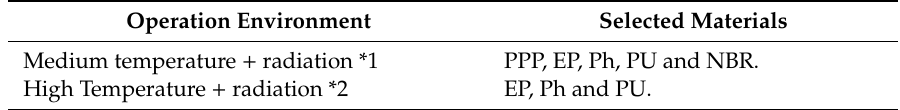
Table 8. Selected materials according to their thermal and radiation tolerance.